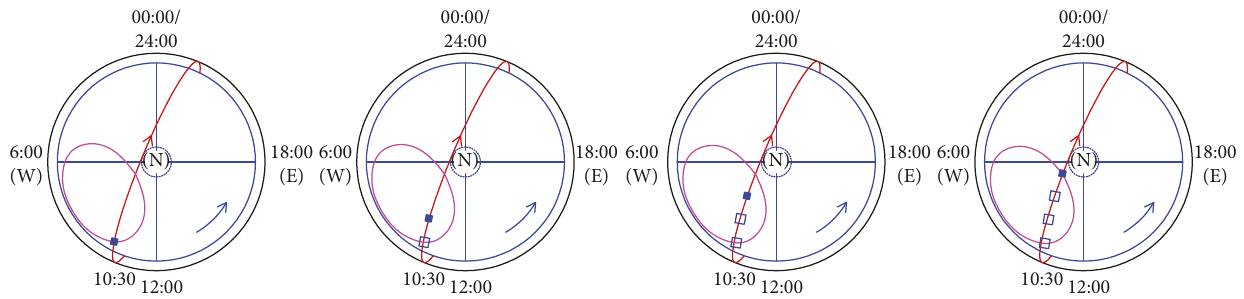
Figure 11: DTUsat-2 is in a Sun-synchronous orbit with a LTAN of 10:30 AM; thus, the orbital plane vector remains locked with respect to the Earth-Sun direction vector. It is the Earth-Sun direction vector that determines time on Earth, thus knowing satellite pass start time enables determination of orbit azimuth, which is used to map out the beacon count numbers.